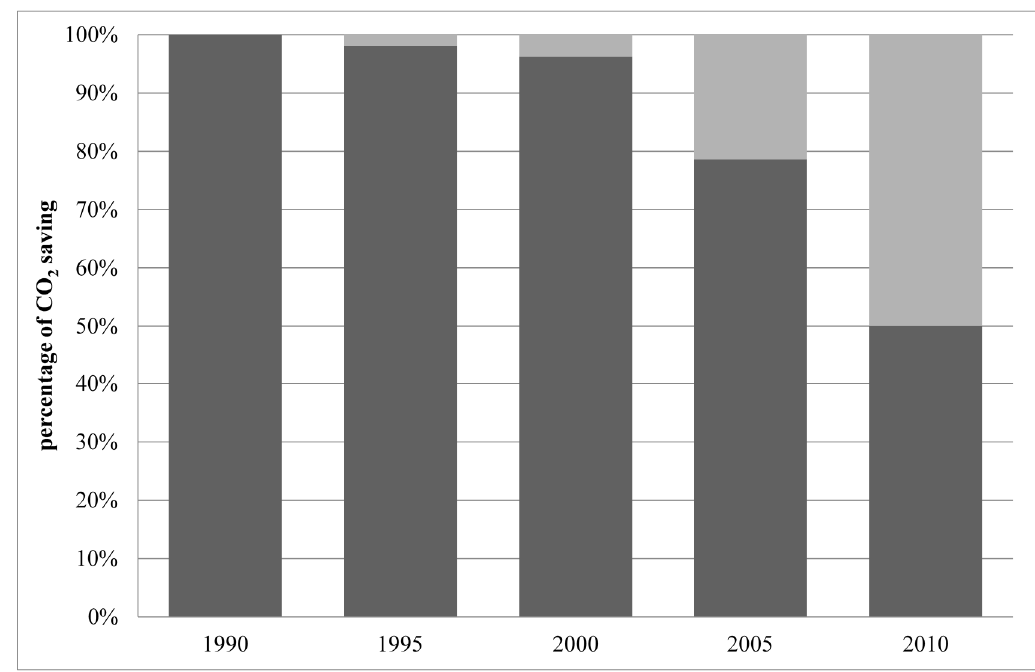
Figure 10. CO 2 saving for households in the Umbria: trend in the years